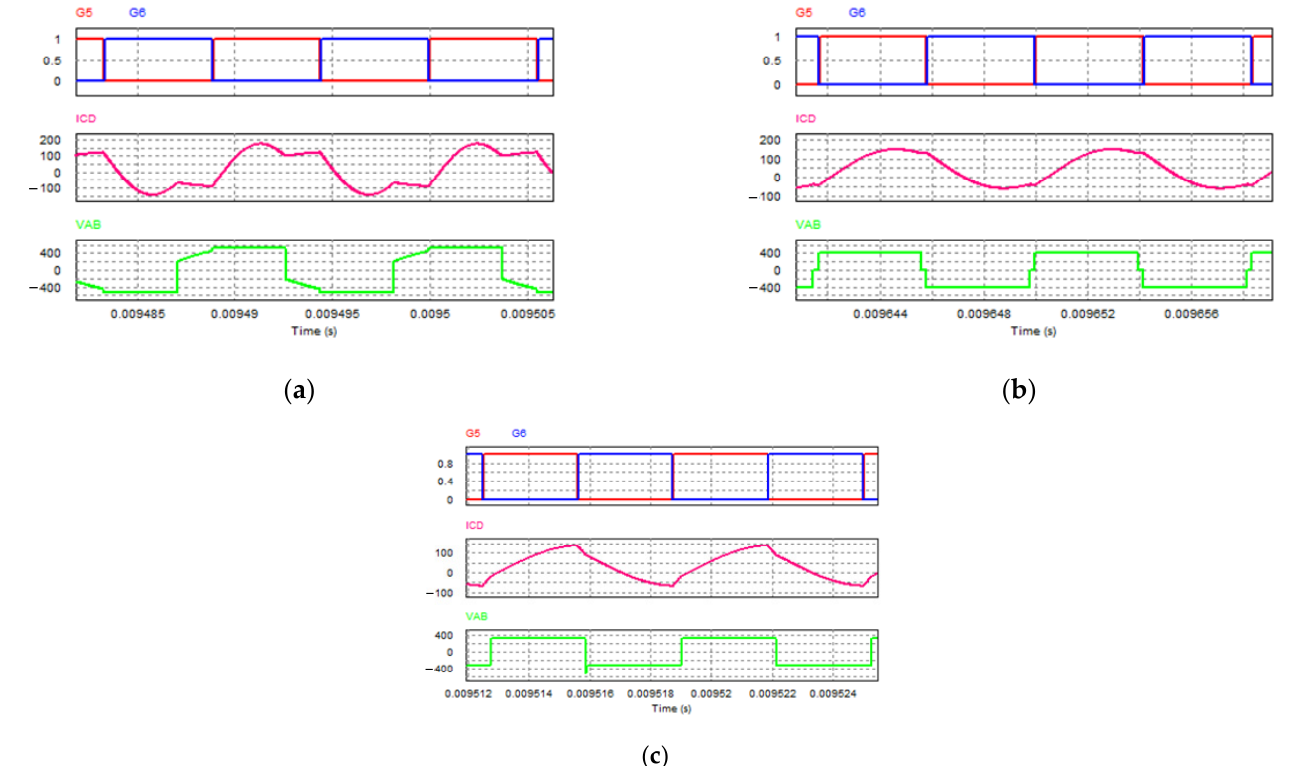
Figure 7. Simulation waveforms in step-up mode, 50 V, 64 Ω : ( a ) 100 kHz; ( b ) 120 kHz; ( c ) 160 kHz.